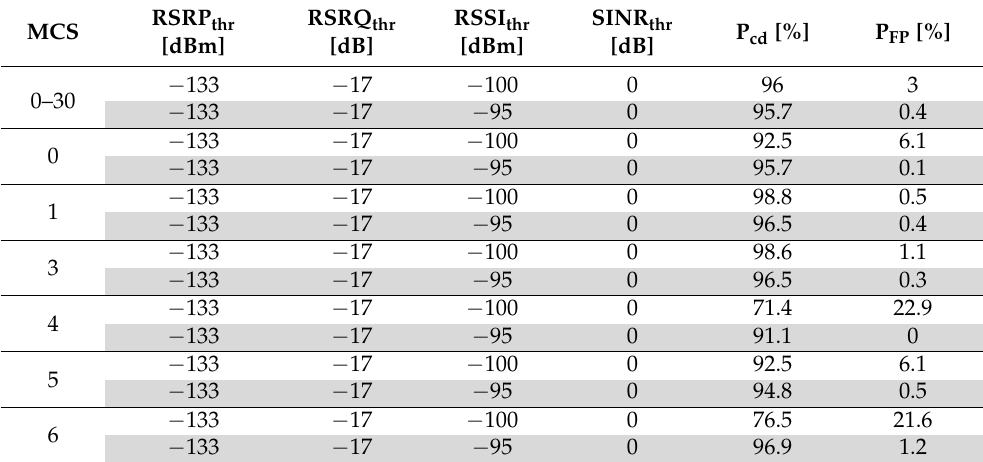
Table 2. Probability of correct decision and positive false decision for selected threshold parameters and different